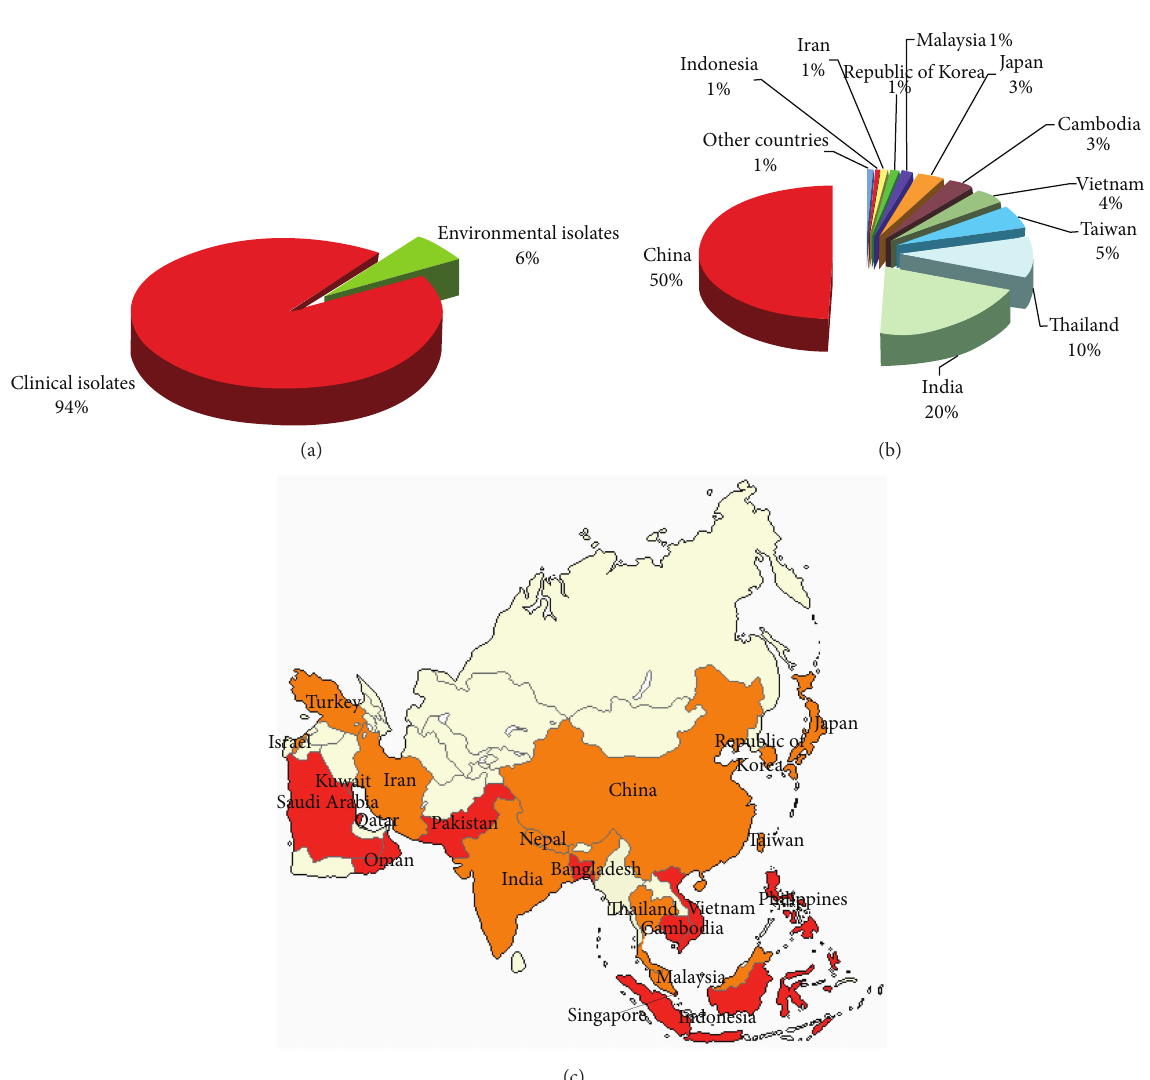
F 3: Percentage of Cryptococcus neoformans and Cryptococcus gattii isolates from clinical ( sources (a). Distribution of Cryptococcus neoformans and Cryptococcus gattii isolates in the different Asian countries (b). Map of the geographical distribution of the Cryptococcus neoformans and Cryptococcus gattii isolates in Asia (c). Clinical isolates were reported from red-colored countries, whereas both clinical and environmental isolates were reported from orange-colored